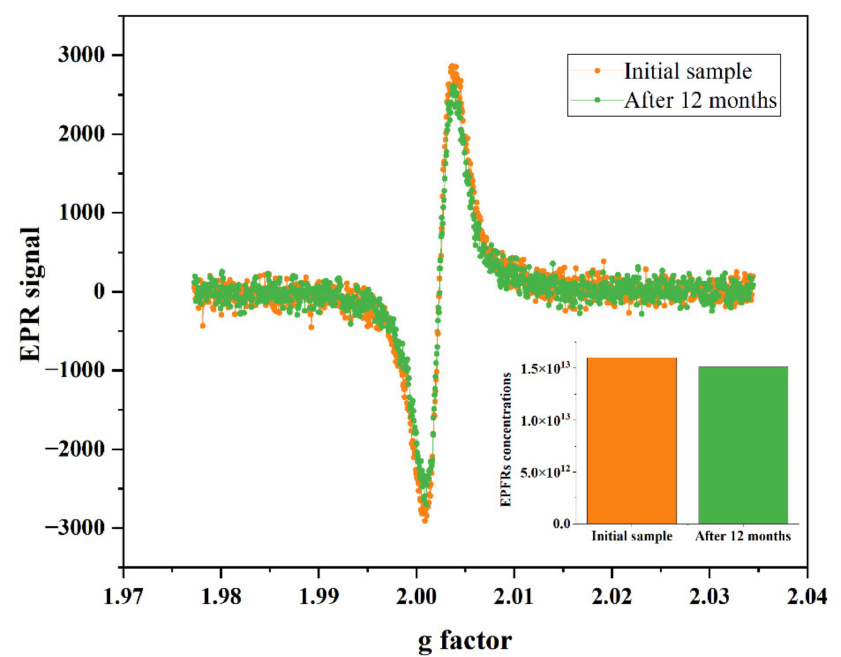
Figure 5. EPFR changes after storage for 12 months. The smaller graph shows EPFR concentration changes and the larger one shows the EPR signal